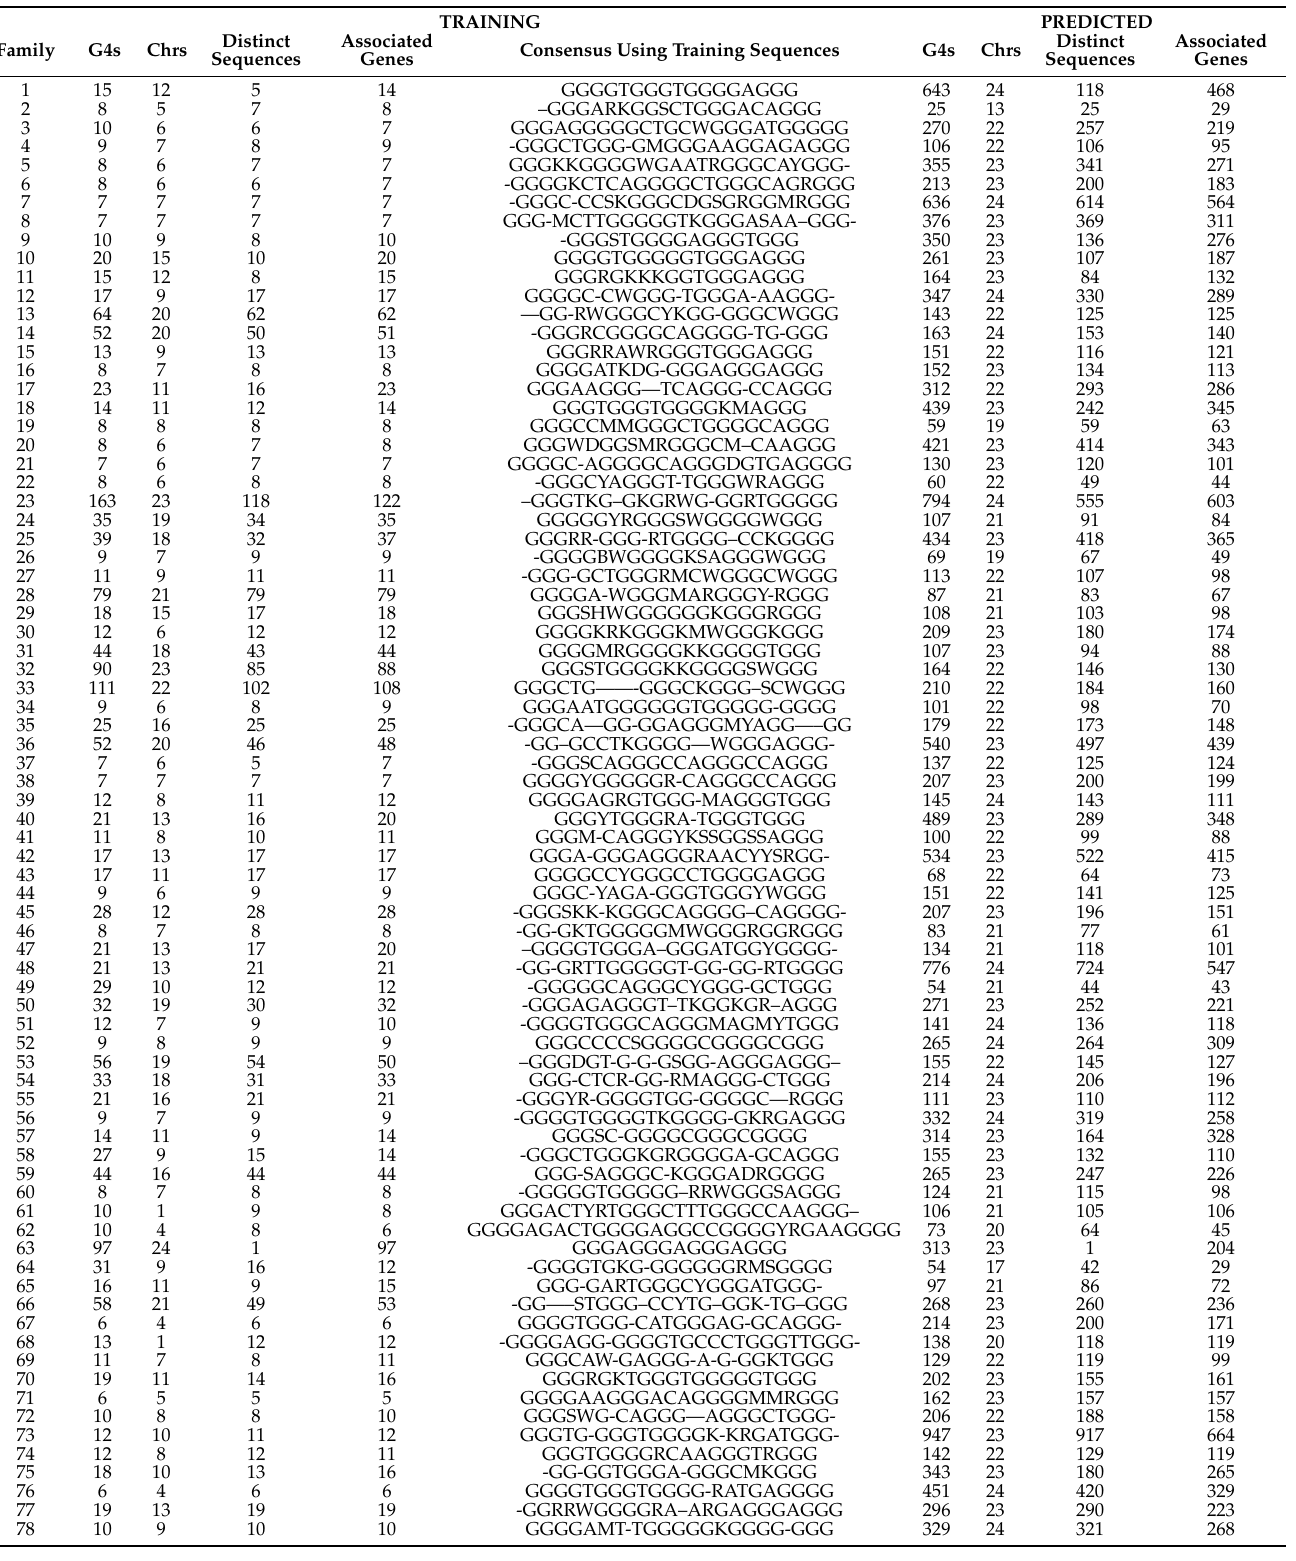
Table 2. Summary of count of G4 sequences identified using predictive models pHMM across different clusters, genes, and